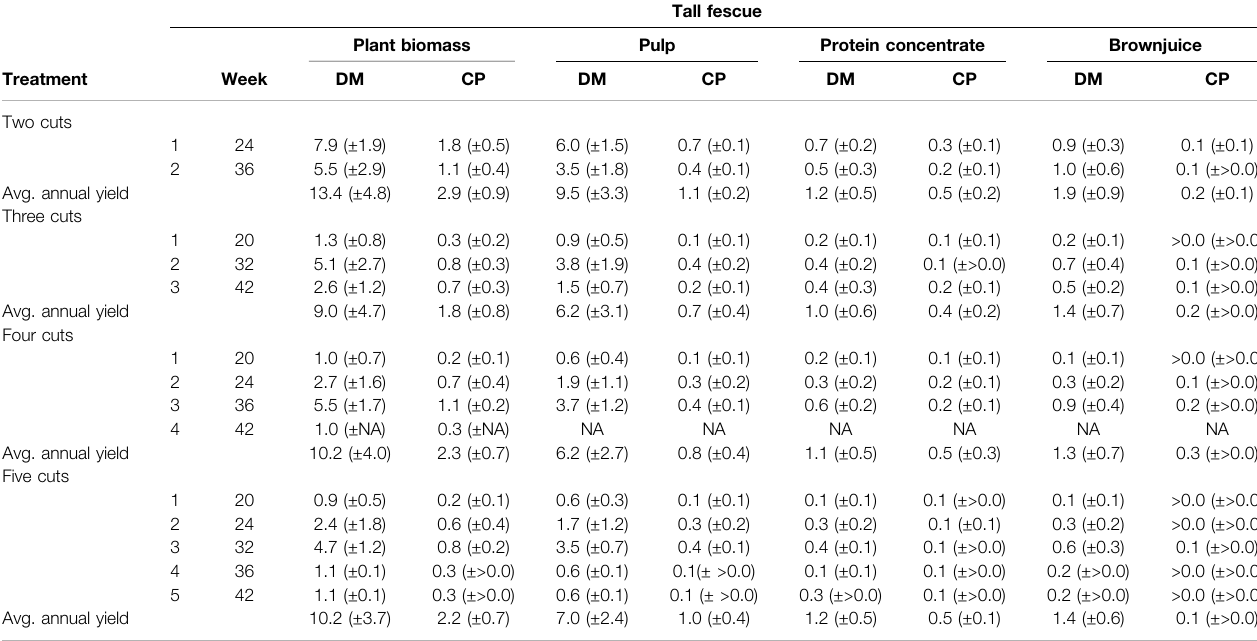
TABLE 4 | Dry matter (DM) and crude protein (CP) yields in plant biomass and screw-pressed fractions for tall fescue. All yields in t ha − 1 year − 1 . Standard deviation (SD) is giving in brackets. Missing SD values due to only one replicate as a consequence of insuf fi cient biomass for processing with the screw-press. Tall fescue Plant biomass Pulp Protein concentrate Brownjuice